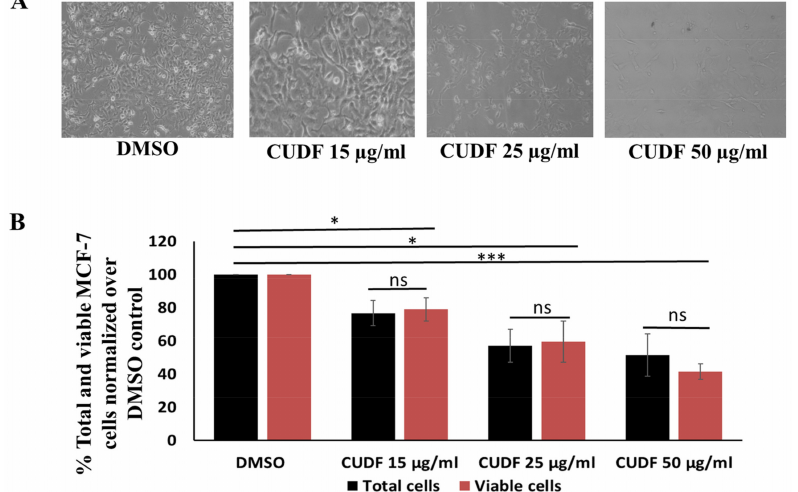
Figure 1. Cow urine DMSO fraction (CUDF) induces loss of cell viability in MCF-7 breast cancer cells. ( A ) MCF-7 cancer cells were treated with DMSO and CUDF (15 µ g/mL, 25 µ g/mL, and 50 µ g/mL) for 72 hr. Routine microscopy was performed at 100 × to observe the cell number and cellular morphology. ( B ) MCF-7 cancer cells were treated with DMSO and CUDF (15 µ g/mL, 25 µ g/mL, and 50 µ g/mL) for 72 h. The percentage total and cell viability of MCF-7 cancer cells were estimated by trypan blue dye exclusion assay and normalized relative to the DMSO control. Data are represented as mean ± SD. Each experiment was conducted independently three times. The bar graph without an asterisk denotes no significant difference compared to the DMSO control. * Significantly different from the DMSO control at p -value ≤ 0.05. *** Significantly different from the DMSO control at p -value ≤ 0.001.